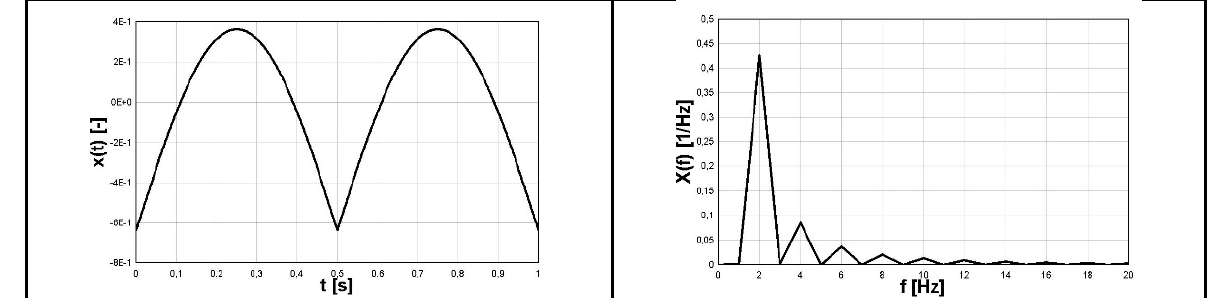
Figure 3. Translated absolute value of harmonic sine function ( left ) and its FFT form ( right ).